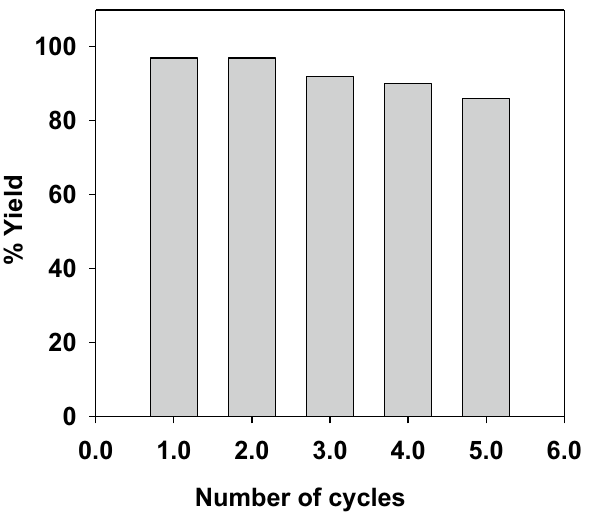
Figure 6. Reusability of Fe 3 O 4 @SiO 2 /Pd 0 /Pd II NP ( 5 ) nanocatalyst towards tandem Suzuki coupling/transfer hydrogenation